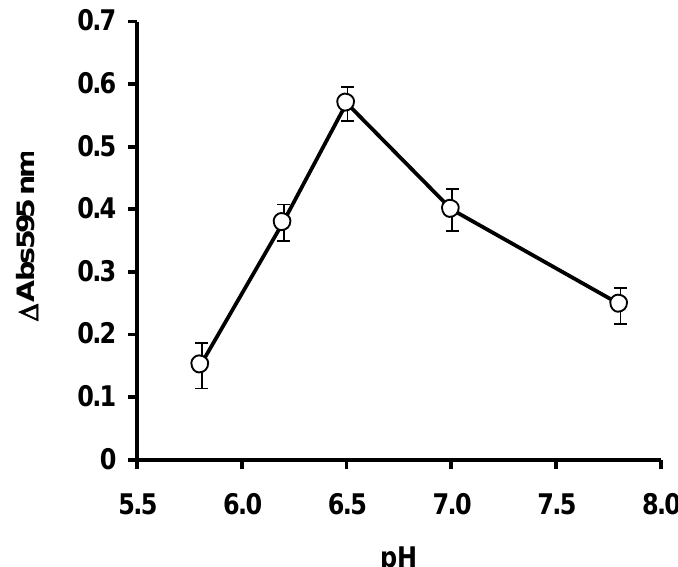
Figure 4. The effect of pH on the ficin dye-binding assay. Error bars represent mean ± standard deviation ( n = 3).